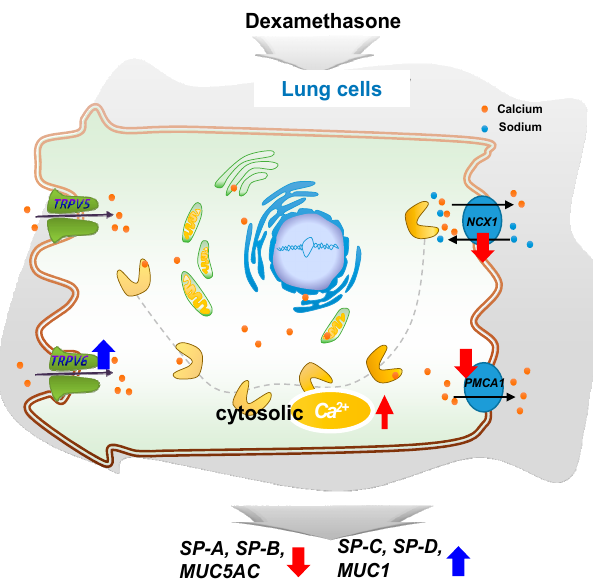
Figure 7. A simplified schematic diagram of the DEX effect on the intracellular calcium level through TRPV6 in A549 cells. DEX influences the intracellular calcium level through TRPV6 and affects the pulmonary surfactant genes ( SFTPA , -B, -C, and -D ) and the secreted airway mucin genes ( MUC1 and MUC5AC ) in A549 cells. ↑ , increase; ↓ , decrease.